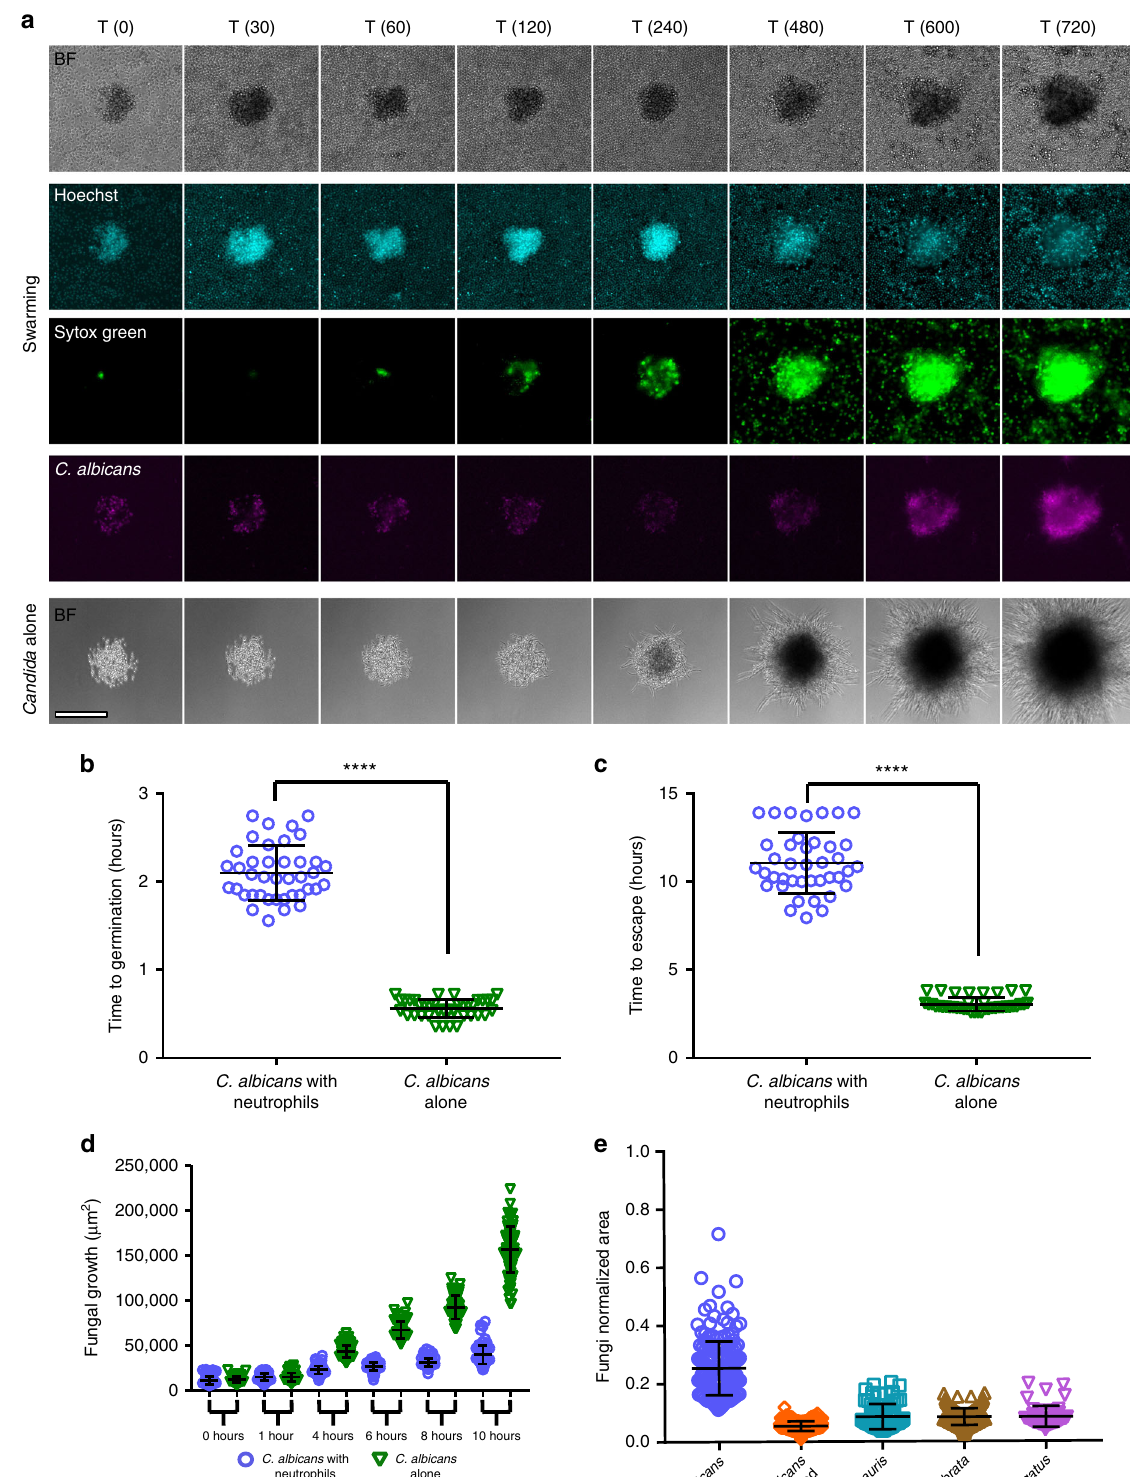
Fig. 3). The swarms formed against C . auris and C . glabrata ended up smaller than those seen against C . albicans , despite the initial clusters being of identical size, demonstrating that the dynamics and magnitude of swarming responses can be dictated by the fungal species being engaged (Fig. 2c – e). Interestingly, C . auris